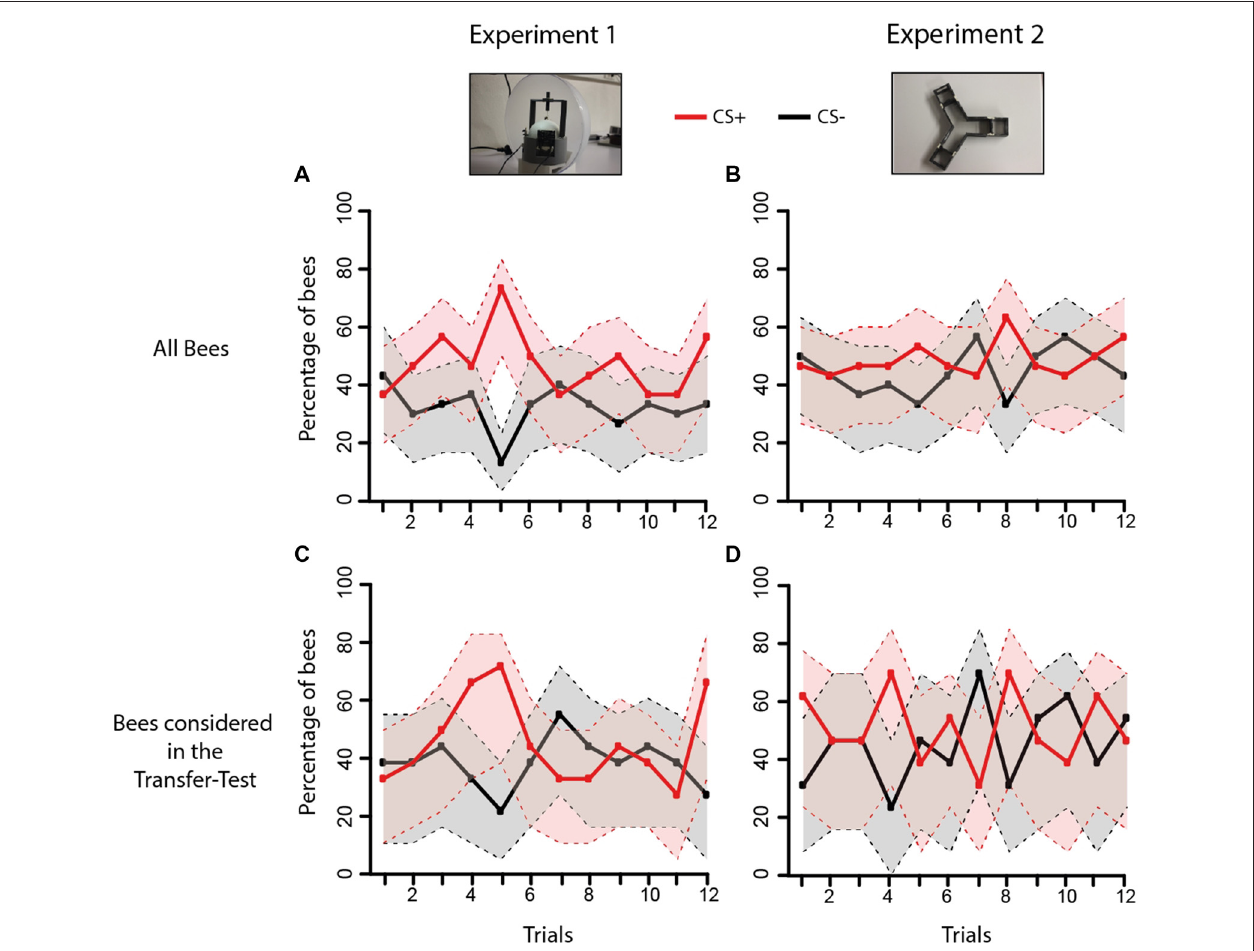
FIGURE 6 | Acquisition performance of bees during Experiments 1 and 2. The graphs show the proportion of bees choosing first the CS+ (red curve) or the CS − (black curve) during the 12 conditioning trials. (A) Acquisition performance of all bees trained in Experiment 1 in the VR setu p ( n = 30); (B) acquisition performance of all bees trained in Experiment 2 in the Y-maze ( n = 30). (C) Same as in (A) but only for bees that made a choice in the post-test and whose performances were consequently analyzed in the transfer test ( n = 21; see Figure 4A ). (D) Same as in (B) but only for bees that made a choice in the post-test and whose performances were analyzed in the transfer test ( n = 24; see Figure 4B ). The gray and pink areas around the curves represent the 95% confidence interval of CS+ and CS − choices,